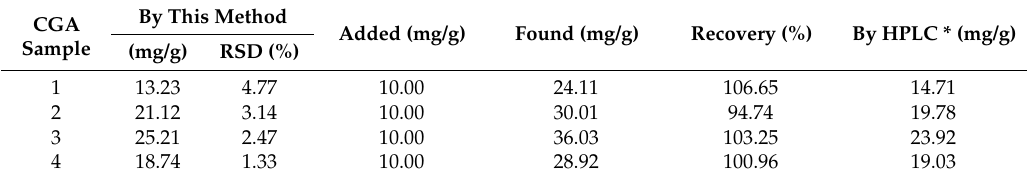
Table 2. Measurement results of CGA in coffee beans (n =